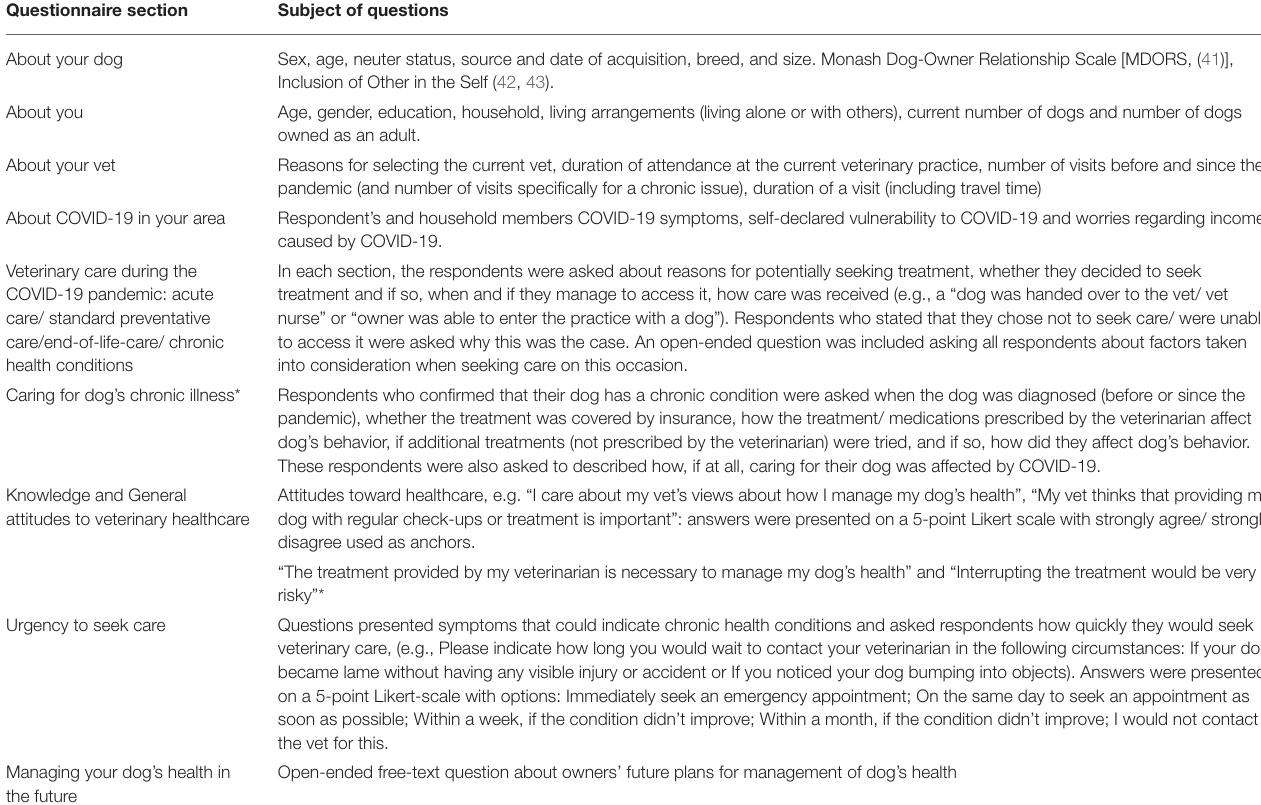
TABLE 1 | Summary of themes of questions used in the survey. Questionnaire